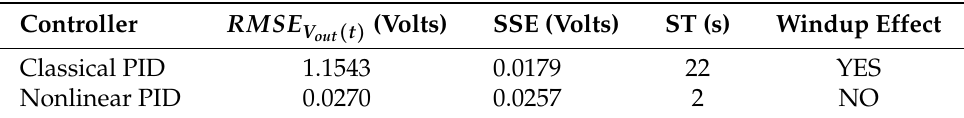
Table 9. System performance during the